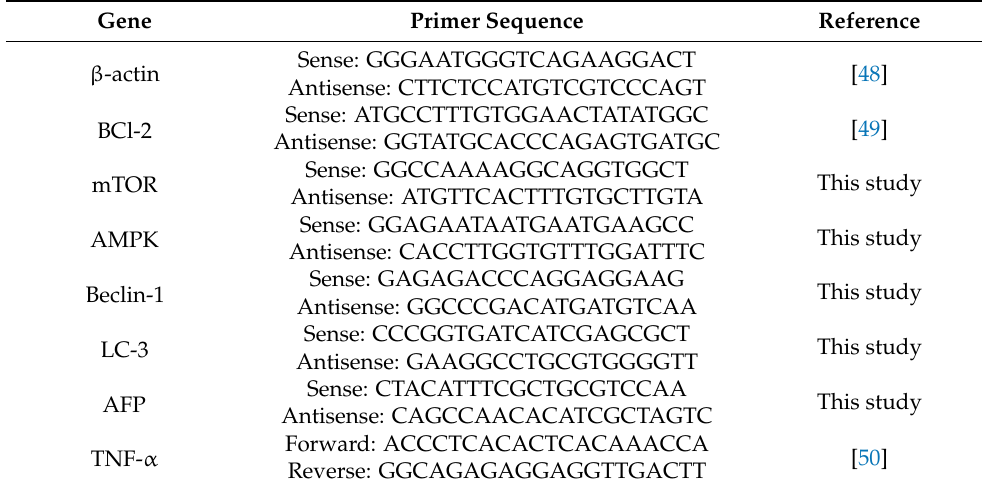
Table 4. Primer sequences for gene expression analysis using